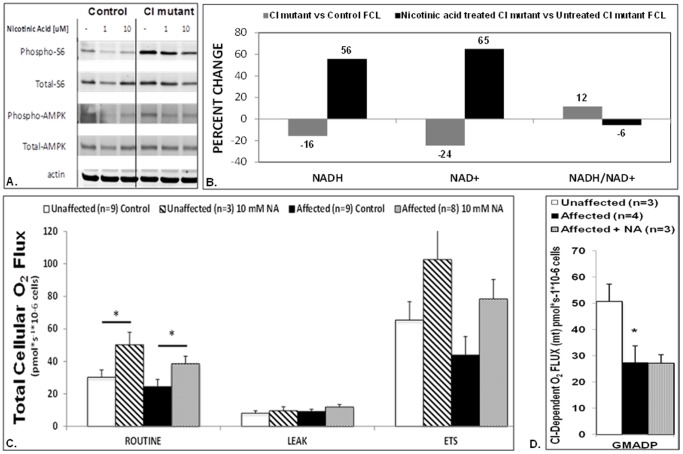
Nicotinic acid treatment in a complex I mutant FCL reverses mTORC1 and AMPK activation and rescues cellular redox poise and respiratory capacity.(A) Upregulated P-S6 and P-AMPK expression in the Q1039 CI mutant FCL was mitigated in a dose-dependent fashion with 24 hour nicotinic acid treatment (lanes 5–6). Cells were grown in the same low glucose concentration (5 mMol) as was used for microarray studies. The proband has Leigh syndrome caused by known pathogenic mtDNA mutations in two complex I subunits, ND4 and ND6 (Fig. 1). (B) Total cellular deficiency in both NADH and NAD+ (as measured by HPLC as pMol/mg protein), along with an increased NADH/NAD+ ratio, was evident in the same CI mutant FCL relative to control FCL (gray). NADH and NAD+ cellular levels, as well as NADH/NAD+ redox balance, were all reversed by 24 hour nicotinic acid (10 mMol) treatment in CI mutant FCLs relative to untreated CI mutant FCLs (black). Percent change in mean [NAD+], [NADH], and calculated NADH/NAD+ ratios are shown, as determined in 3 biologic replicates per condition. (C) Intact FCLs from the same Q1039 CI-mutant proband (black) showed no significant change in total cellular routine (basal) respiratory capacity relative to unaffected control (white) oxygen flux as measured by high-resolution respirometry (Oxygraph-2K, Oroboros). However, nicotinic acid (10 mmol) treatment for 24 hours significantly increased total cellular respiratory capacity both in control (slash) and affected (dotted) cells. *, p<0.05 by ANOVA followed by paired t-test. Maximal (electron transport system, ETS) respiration was significantly greater than routine respiration for three of the conditions studied (CI mutant cells with no treatment, p = 0.0033; CI mutant cells with nicotinic acid treatment, p = 0.007, and control cells with no treatment, p = 0.002 by paired t-tests. No significance was reached when comparing basal and maximal respiratory for the nicotinic acid treated control cells, possibly due to small sample size (n = 3, p = 0.1126). Leak (background or non-mitochondrial) respiration showed no difference in any condition. Bars indicate mean±SEM. (D) Digitonin-permeabilized fibroblast analyses (right panel) reliably discriminated the specific complex site of RC dysfunction in affected CI mutant (Q1039) cells (black), as complex I-dependent (“GMADP, glutamate+malate+ADP) cellular respiratory capacity was significantly reduced in CI mutant FCLs relative to unaffected control FCLs (white). The genetic-based deficiency in CI-dependent respiratory capacity was not improved by 24 hour treatment with nicotinic acid (10 mMol, gray). Bars indicate mean±SEM. *, p<0.05.